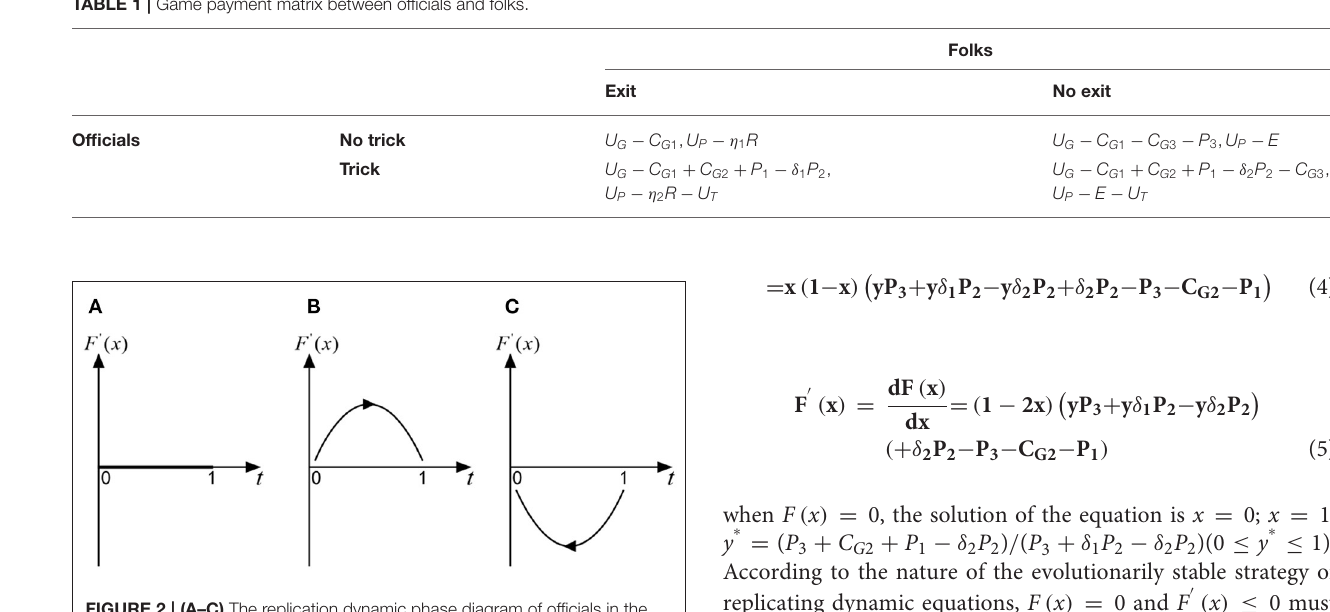
FIGURE 2 | (A–C) The replication dynamic phase diagram of officials in the official-folk